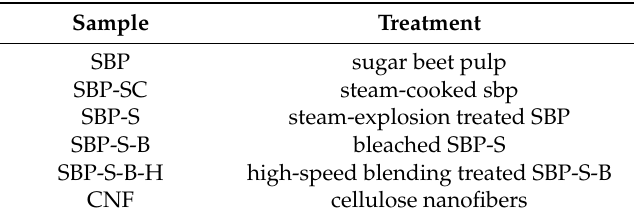
Table 1. The name of samples in different